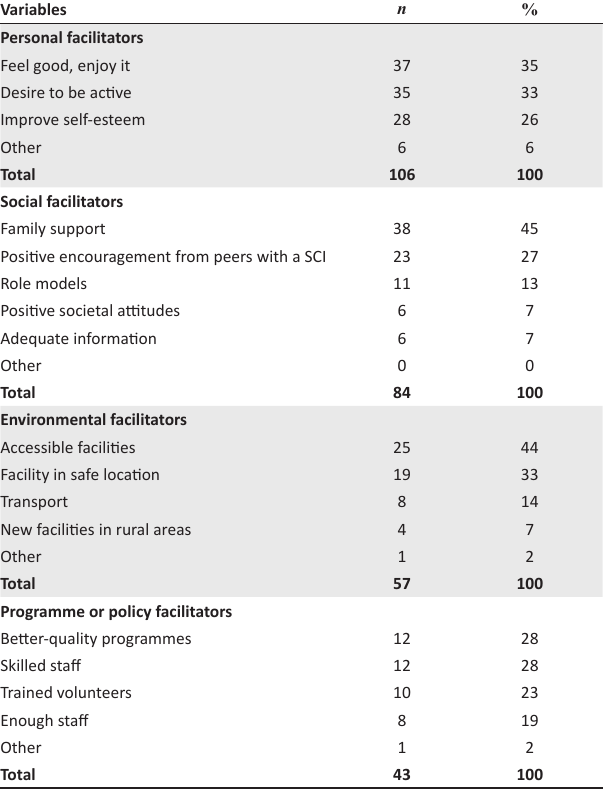
TABLE 2: Reported facilitators to physical activity. Variables n % Personal